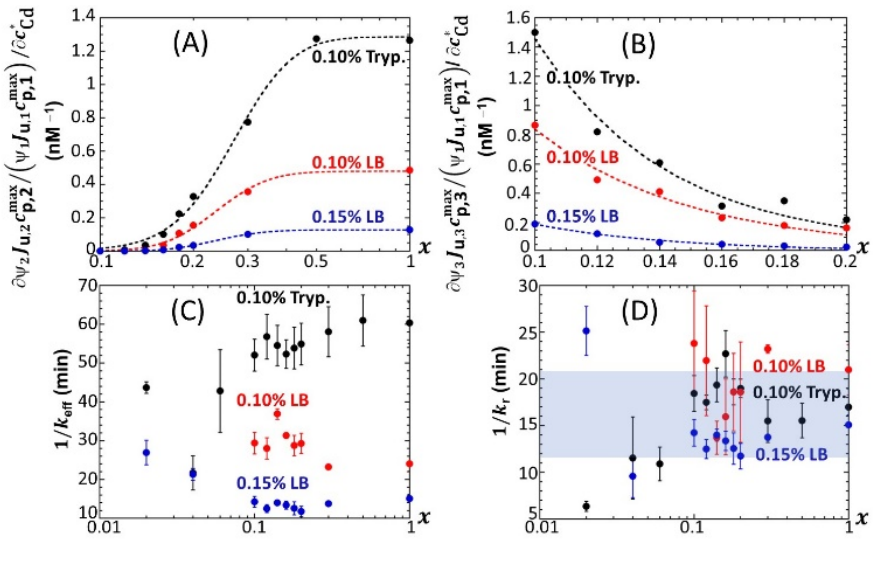
Figure 12. ( A , B ) Slopes of the linear variations of R i = 2,3 with c ∗ Cd reported as a function of x in 0.1% tryptone, 0.1% LB and 0.15% LB media (indicated). Values of the timescales ( C ) 1/ k eff and ( D ) 1/ k r as retrieved from recovery of measured time-dependent bioluminescence profiles (corrected for the corresponding reference measured at 0 nM concentration) with theory over the range of x conditions tested in 0.1% tryptone, 0.1% LB and 0.15% LB media (indicated). See text and Section 3 for